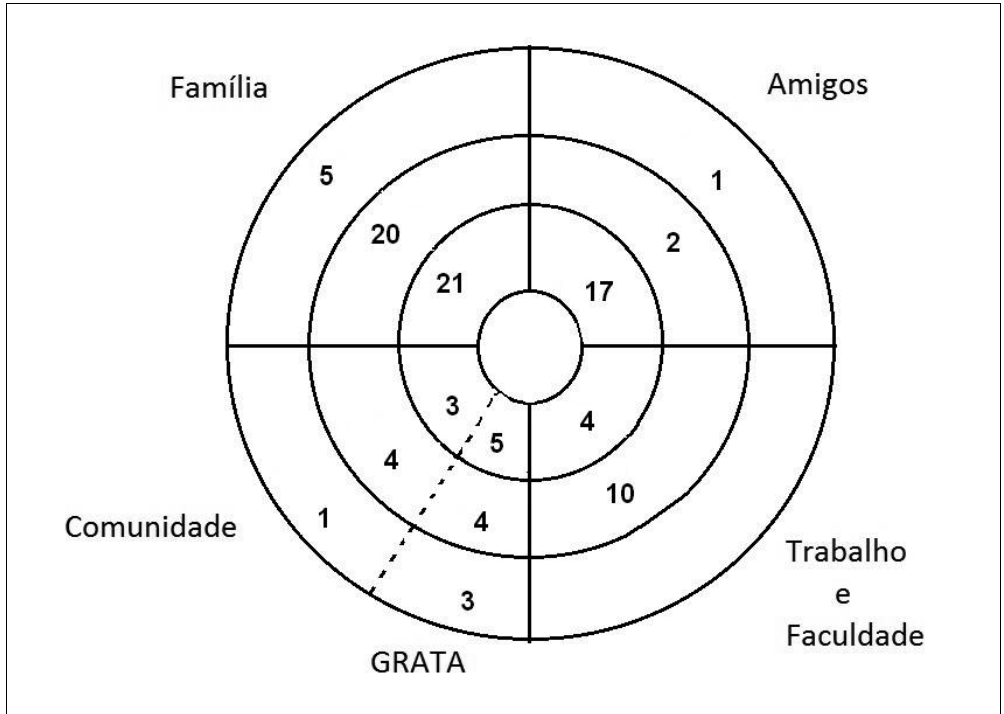
Figura 2 . Distribuição dos membros das redes de todas as participantes nos quadrantes dos Mapas de Rede.